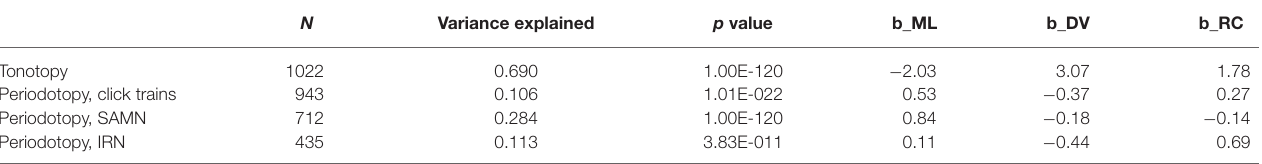
TABLE 2 | Comparison of results of regression analysis to quantify putative periodotopic gradients in the phase-locking limits illustrated in Figure 13. N Variance explained p value b_ML b_DV b_RC